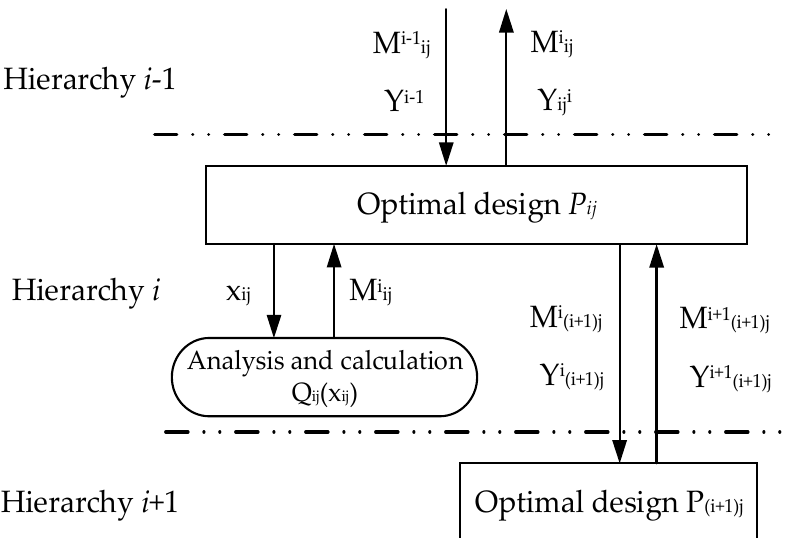
Figure 3. Interactive schematic diagram at each ATC level.